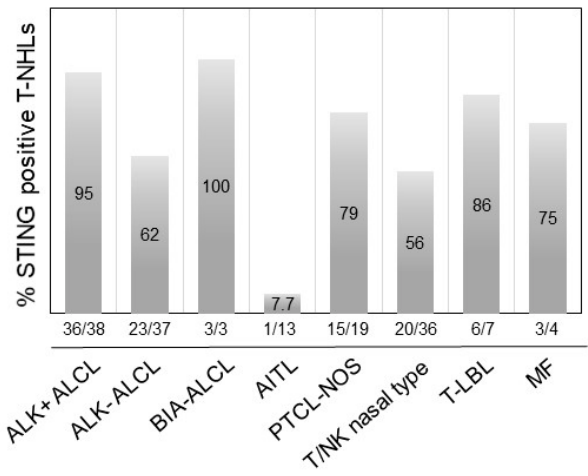
Figure 5. Distribution of STING expression frequency among common histological types of T/NK- cell lymphomas. STING expression was most frequent in BIA-ALCL, ALK+ ALCL, and T-LBL, followed by other T/NK-cell NHLs. The difference in the frequency of STING expression among the histological types of T/NK-cell lymphoma was statistically significant ( p < 0.001 by chi-square test).